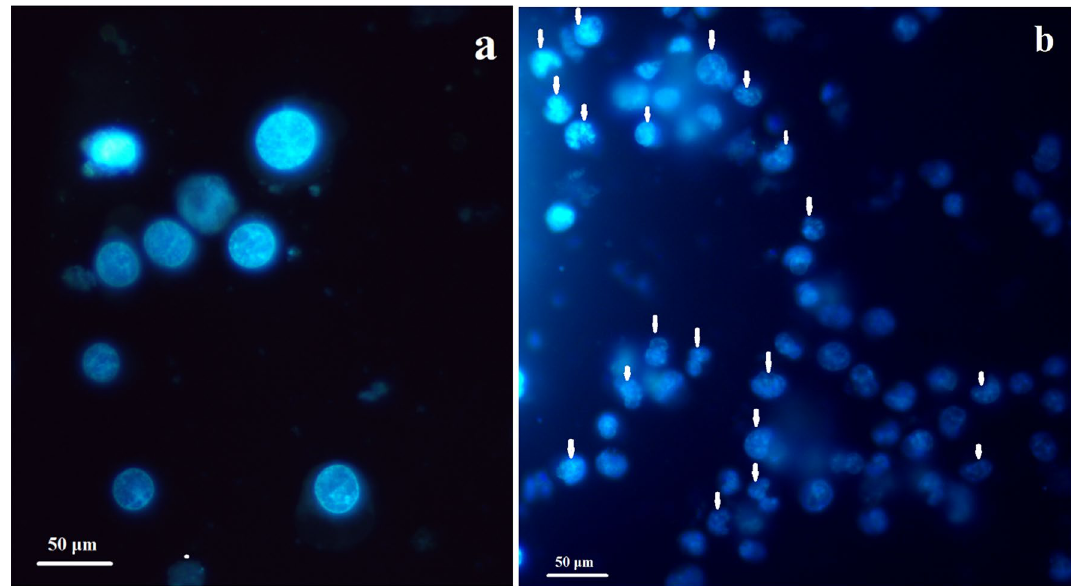
Figure 10. Hoechst staining of ( a ) control, and ( b ) Bi 2 O 3 /Gln-TSC NPs treated cells. The arrows show the chromatin condensation and fragmentation and also the appearance of apoptotic bodies in the cells treated with Bi 2 O 3 /Gln-TSC